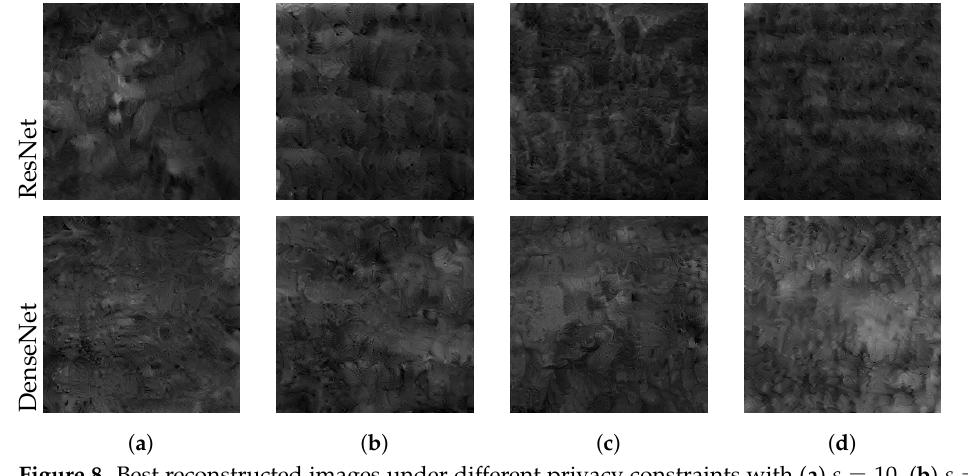
Figure 8. Best reconstructed images under different privacy constraints with ( a ) ε = 10, ( b ) ε = 6, ( c ) ε = 3, ( d ) ε = 1. Private training successfully prevents the leakage of any visible features. Table 8. Mean PSNR over three attack trials on non-private and private local models from a Mendeley client holding one training image. The attack failed for all considered ε values.